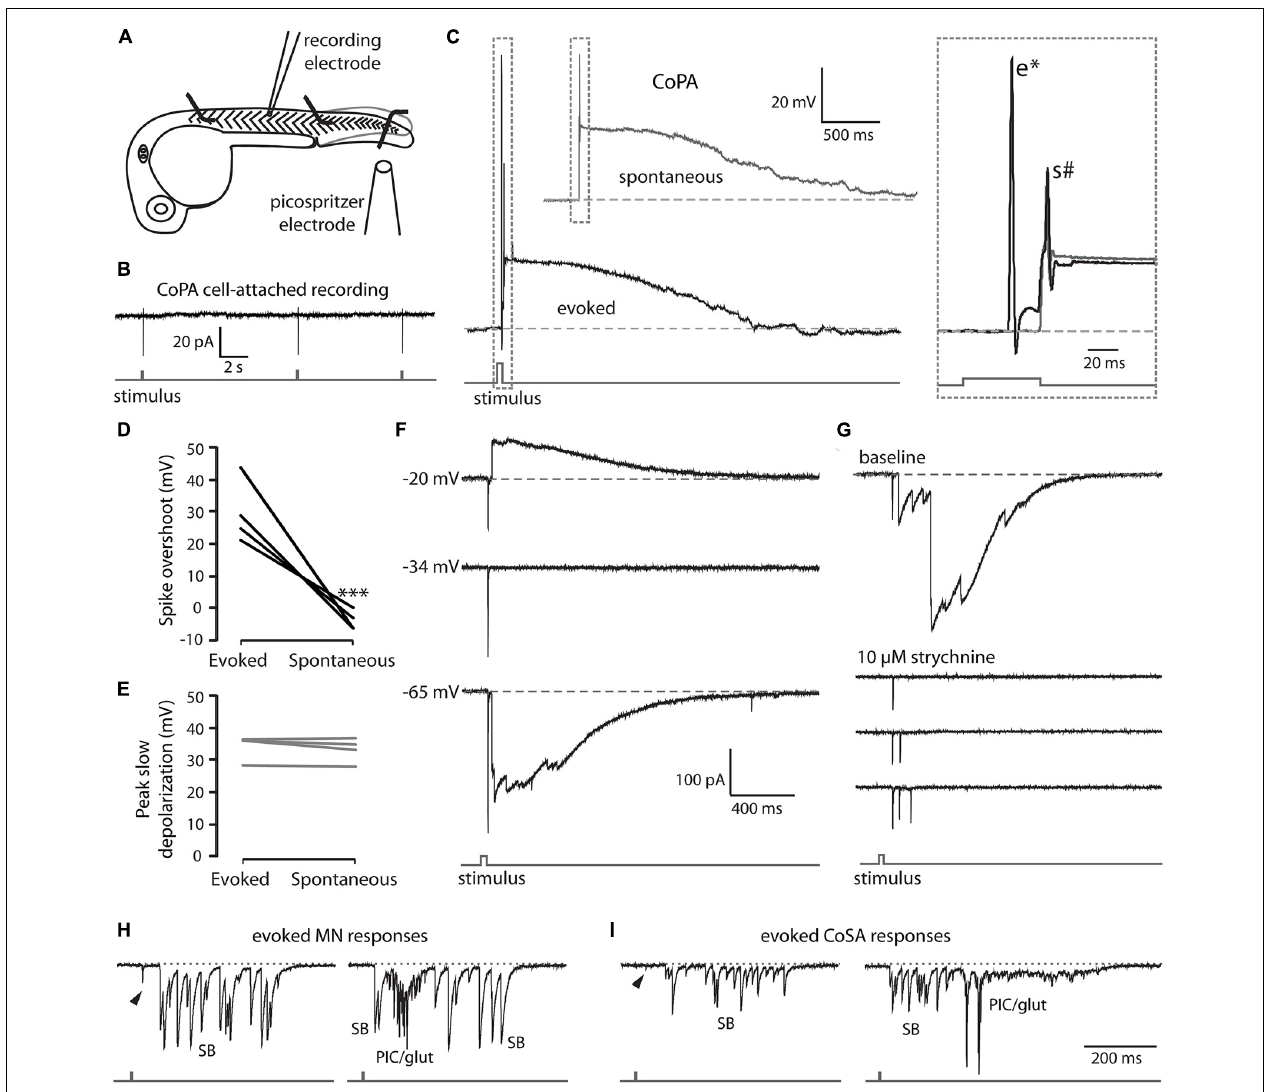
FIGURE 5 | EmbryonicCoPAs receive brief glutamatergic excitation then long lasting, shunting glycinergic inputs in response to touch. (A) Cartoon depicting the experimental set-up for recording touch-evoked responses. (B) Representative cell-attached recording of single spikes consistently elicited in CoPAs (upper trace) in response to touch stimuli (lower trace). No spontaneous spikes were seen in the absence of stimuli. N = 3. (C) Representative current-clamp recordings of a spontaneous event (upper trace, gray) and an evoked event (middle trace, black, and lower stimulus trace, gray) in a 26.5 hpf embryo. Inset, expanded view of the overlapping traces to show the presence of a large amplitude action potential (e*) occurring in the evoked event only and a second smaller action potential (s#) occurring in both events. (D) Comparison of the average overshoot reached by the first spike in an evoked vs. spontaneous event ( ∗∗∗ p < 0.001; Student’s t -test for each neuron between event